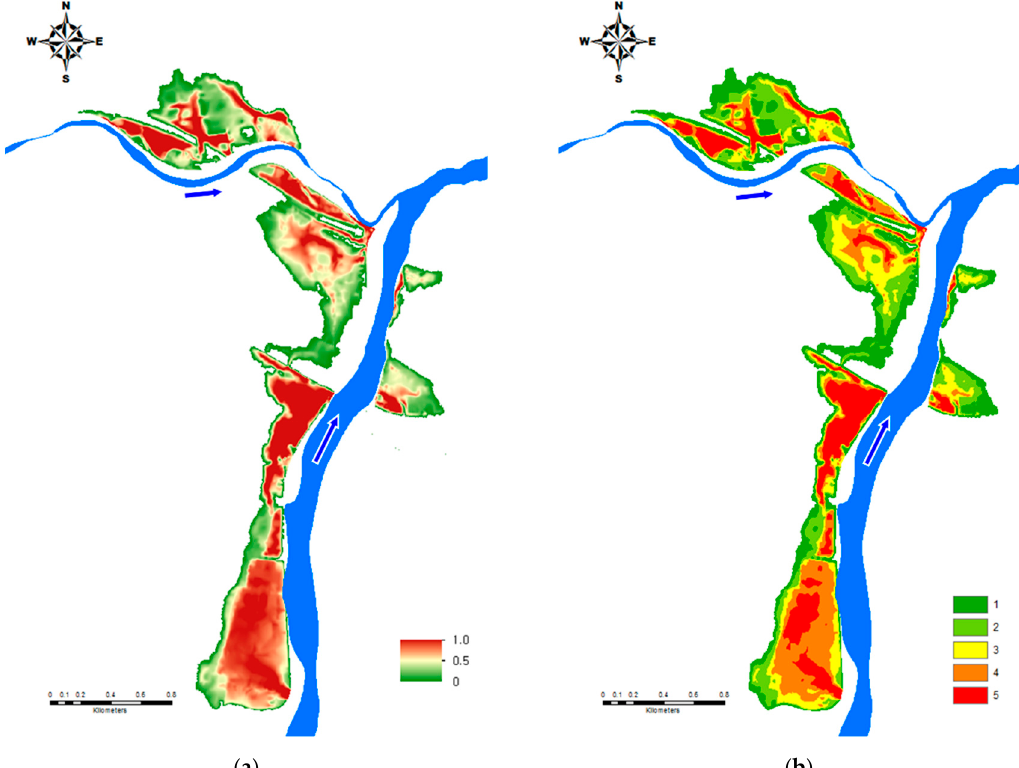
Figure 14. Flood hazard map for levee failure. ( a ) Closeness coefficient and ( b ) flood hazard grade.